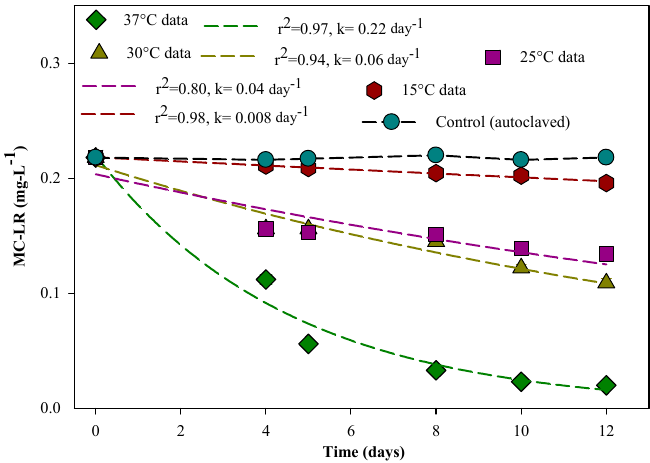
Figure 5. Degradation of MC ‐ LR by the isolated strain Bacillus sp. (8.4 × 10 6 CFU/mL) under different temperatures. k is the first order degradation rate constant. The error bars represent one standard deviation for three measurements.